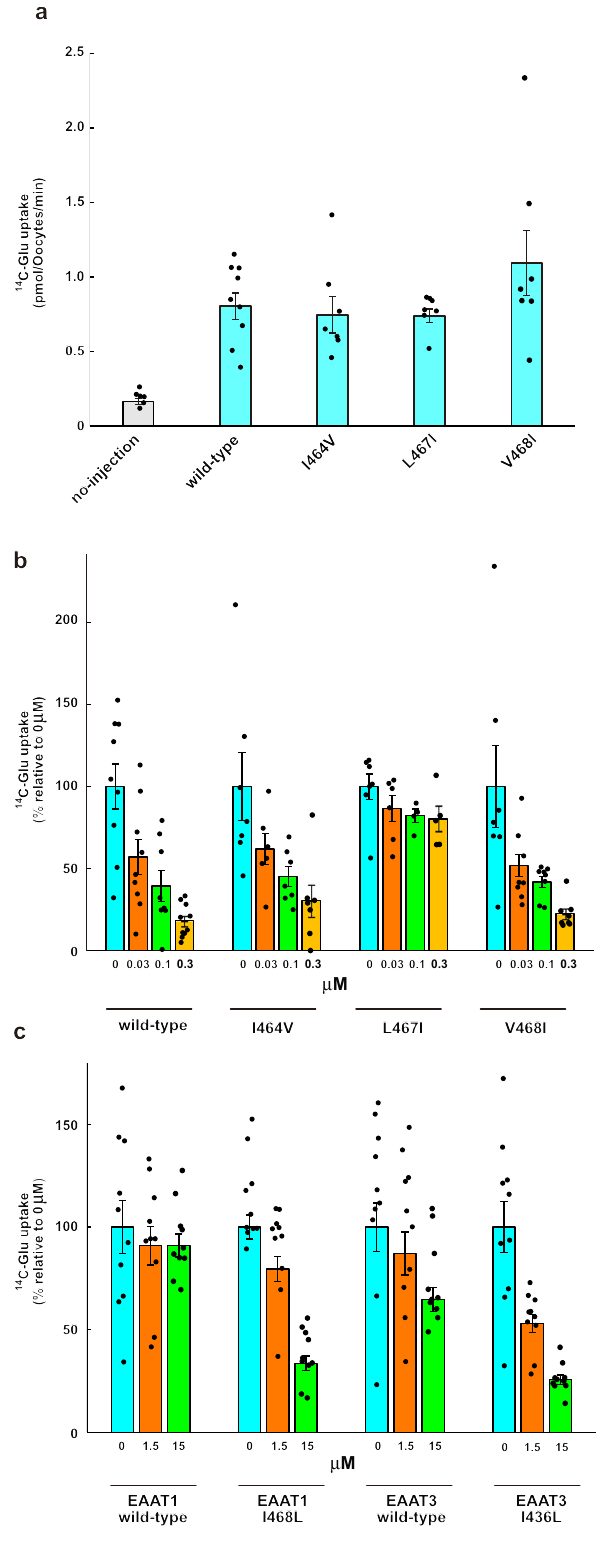
Fig. 5 | Sensitivity of WAY213613. a Glutamate-uptake of each mutant, using Xenopus oocytes. Values are mean±s.e.m. n = 6 – 9 technical replicates ( n =6, 9, 7, 7,and7forno-injection,WT,I463V,L467,andV468I). b Glutamate-uptakeassayfor point mutants treated with WAY213613. Values of vertical and horizontal axes are relative to each 0 μ M and concentration points (0, 0.03, 0.1, and 0.3 μ M) of WAY213613, respectively. Values are mean±s.e.m. n = 4 – 10 technical replicates ( n =9, 9, 8,and 10 for WT in0,0.03, 0.1, and 0.3 μ M, respectively. n =7, 6, 7, and 7 for I463V in 0, 0.03, 0.1, and 0.3 μ M, respectively. n =7, 6, 4, and 5 for L467I in 0, 0.03, 0.1, and 0.3 μ M, respectively. n =6, 9, 8, and 8 for V468I in 0, 0.03, 0.1, and 0.3 μ M, respectively). c Glutamate-uptake assay for point mutants of EAAT1 and EAAT3 treated with WAY213613. Values of vertical and horizontal axes are relative to each 0 μ M and concentration points (0, 1.5, and 15 μ M) of WAY213613, respec- tively. Values are mean±s.e.m. n = 10 technical replicates for each transport